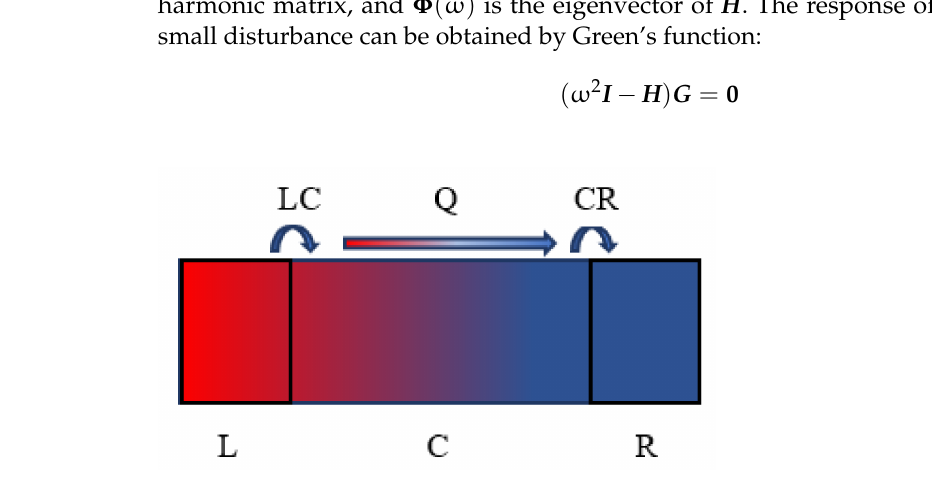
Figure 1. Schematic diagram of heat transport model for low dimensional system. (The L, C and R in the figure represents three parts of the system: central scattering region, left and right lead, and Q indicates the direction of heat